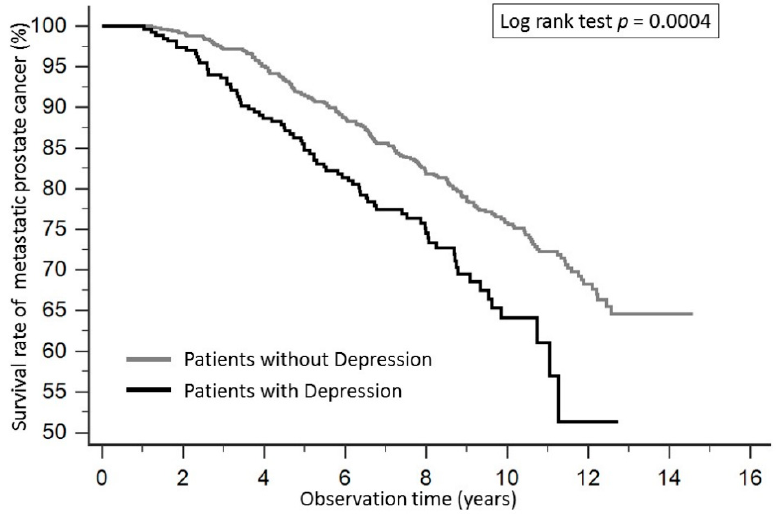
Figure 3. The Kaplan-Meier survival curve for patients with metastatic prostate cancer according to depression. Patients with depression in the metastatic prostate cancer group had significantly lower survival rates compared with patients without depression, and the p value of log-rank test was 0.0004.